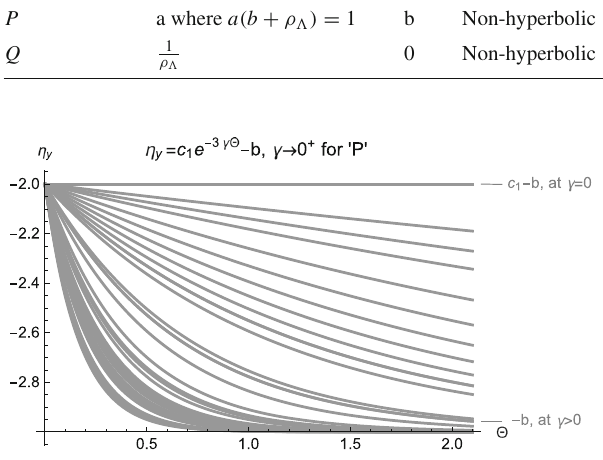
Fig. 13 Variation of η y with respect to (cid:16) for fixed point P as γ → 0 +